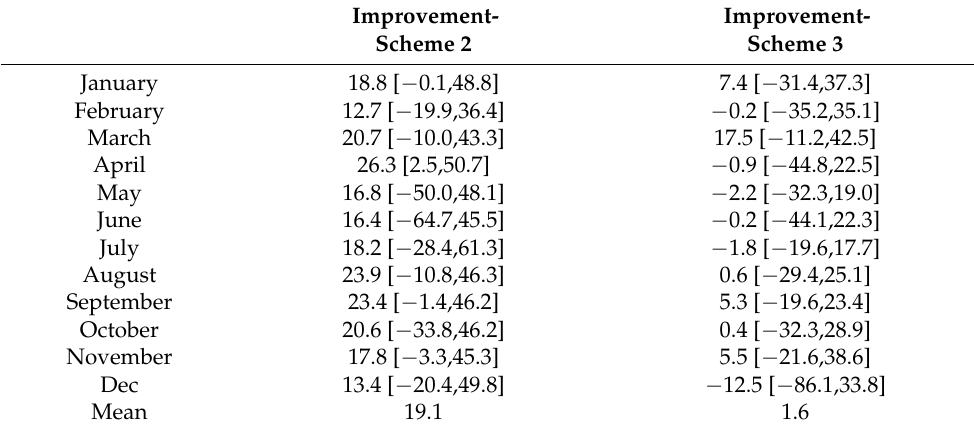
Table 4. Improvement rate of Schemes 2 and 3. Values in brackets refer to the monthly minimal and maximal improvement rate for 10 verifying stations. Unit is percent. Improvement- Improvement- Scheme 2 Scheme